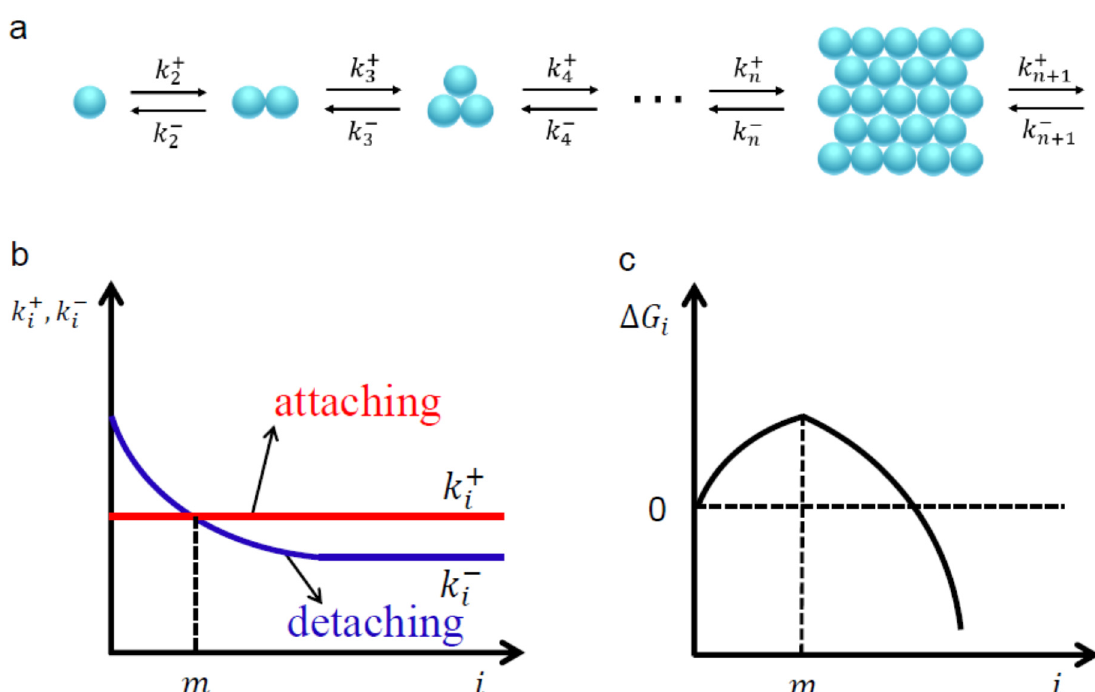
Figure 6. Microscopic kinetics of nucleation of small molecular crystals. ( a ) Scheme showing the microscopic process of attaching and detaching. k + and k − indicate the rate constant for attaching a molecule to form a nucleus containing i molecules and detaching a molecule from a nucleus containing i molecules; ( b ) variation of the rate constants of attaching and detaching with nuclei size; ( c ) free energy change of formation of nuclei containing different numbers of molecules. The symbols i and m indicate the number of molecules within the nucleus and that within the critical nucleus, respectively.